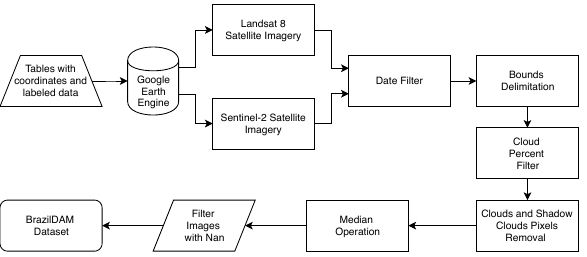
Figure 1. Workflow that illustrates the image acquisition.